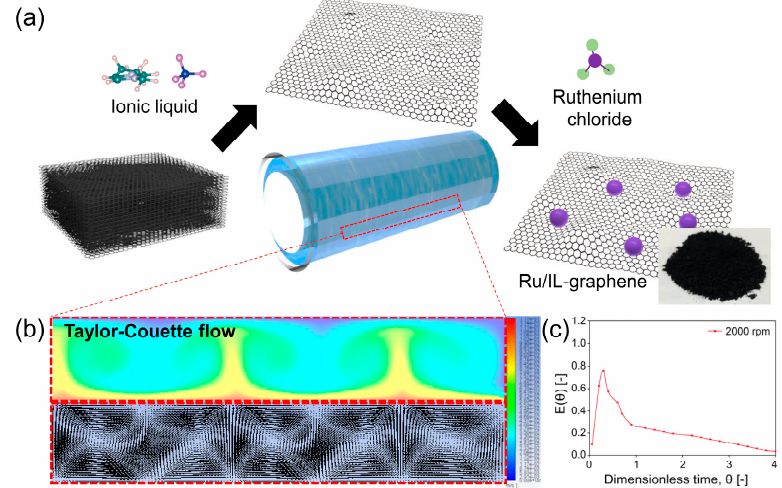
Figure 1. ( a ) Schematic illustration of the hydrodynamic synthesis for ionic liquid (IL)–graphene and RuO 2 /IL–graphene. Photograph image of RuO 2 /IL–graphene powders. ( b ) Computational fluid dynamics (CFD) data of xz axis and tangential velocity diagram and contour at 2000 rpm. ( c ) Residence time distribution (RTD) profiles measured at 2000 rpm.